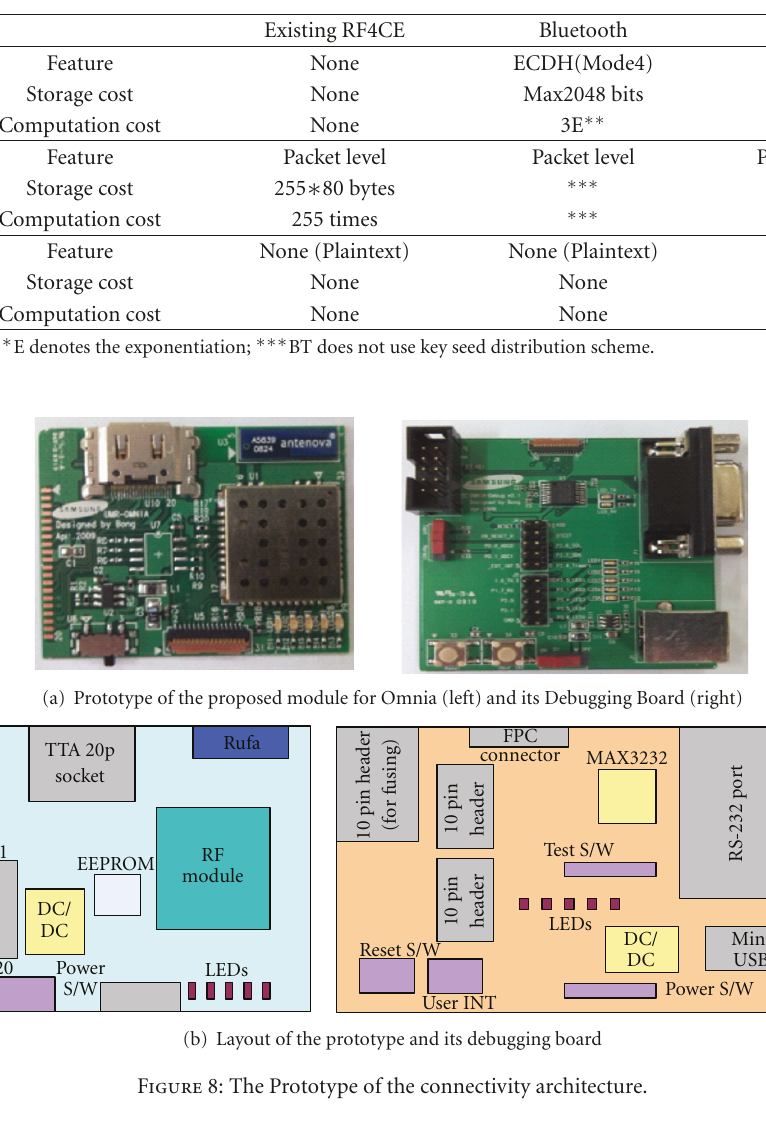
Table 3: Security analysis and comparisons.